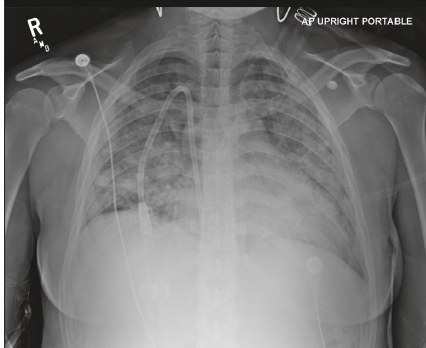
Figure 2: Portable chest radiograph demonstrates diffuse bilateral patchy